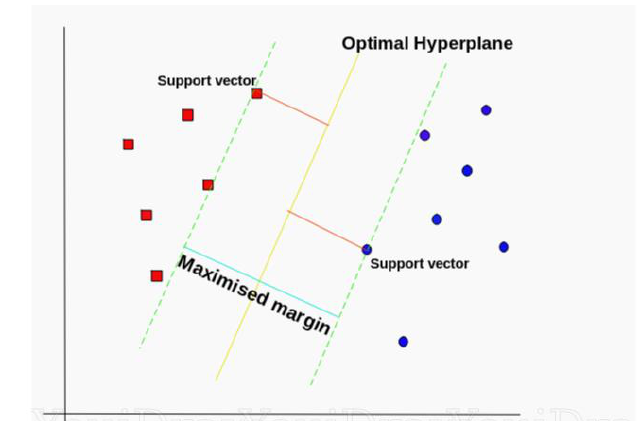
Figure 5. Optimal hyperplane [37].